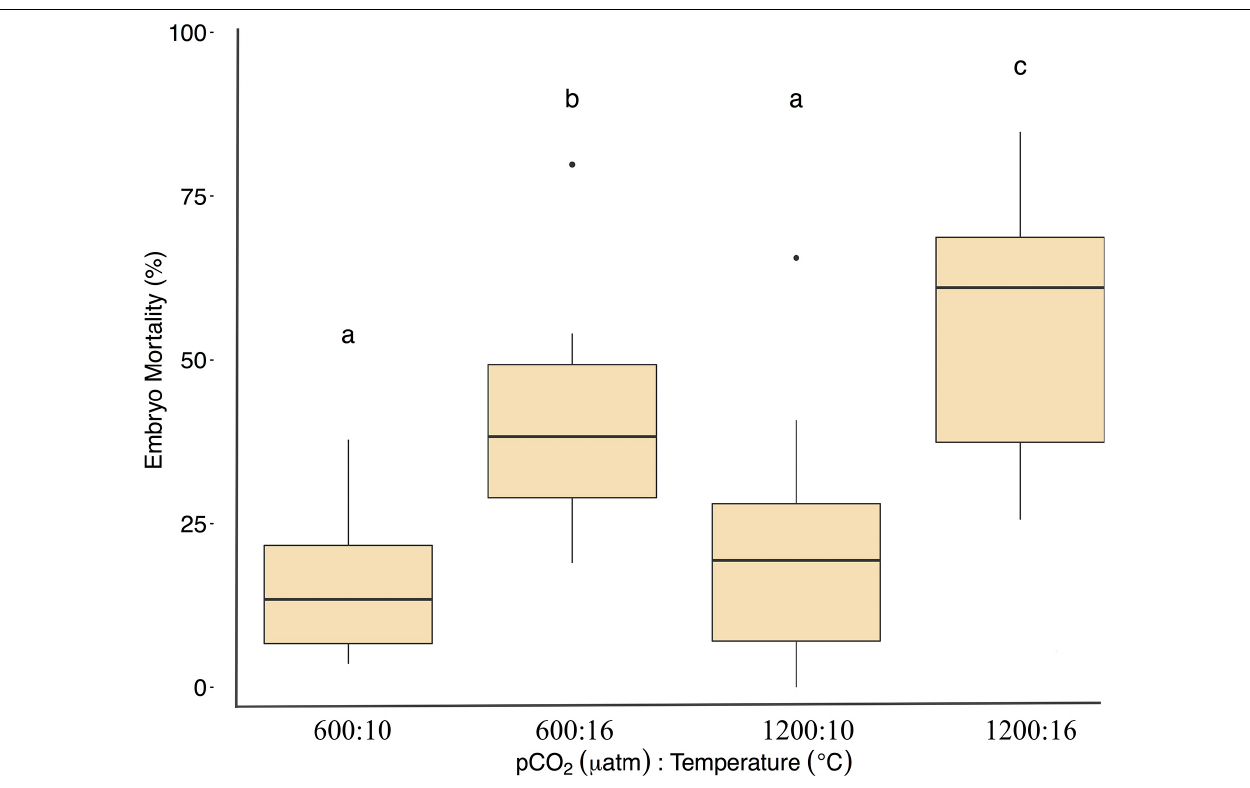
Frontiers in Marine Science |